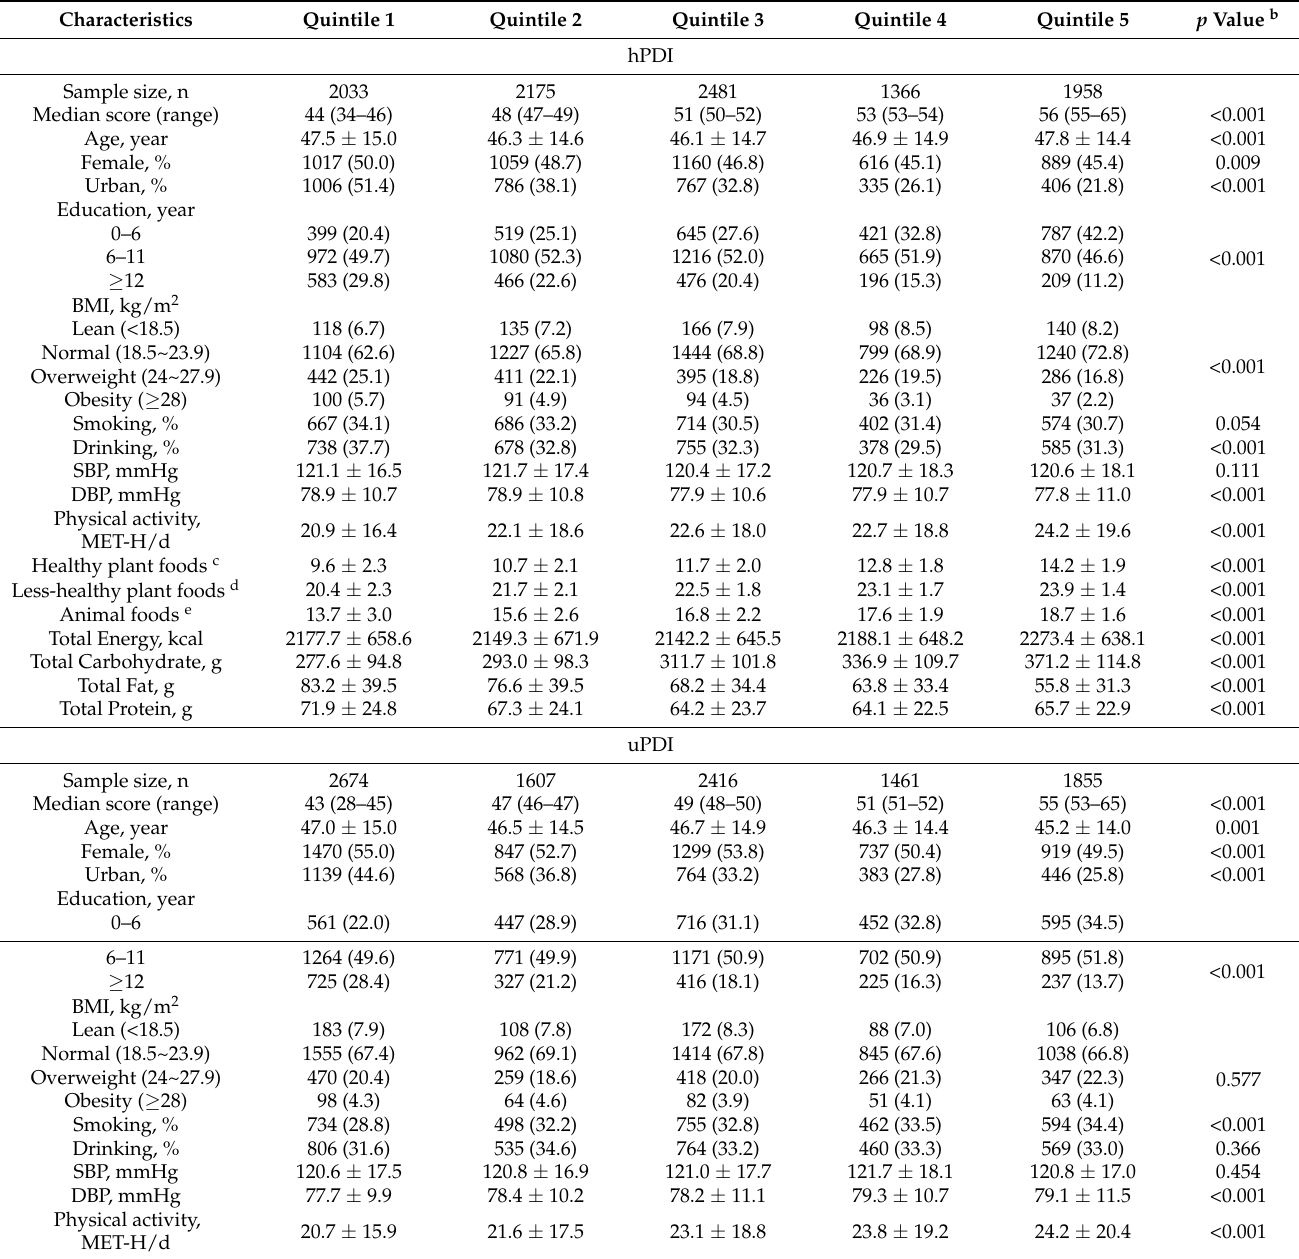
Table 1. Baseline characteristics of CHNS according to quintiles of plant-based diet indices ( n = 10,013) a